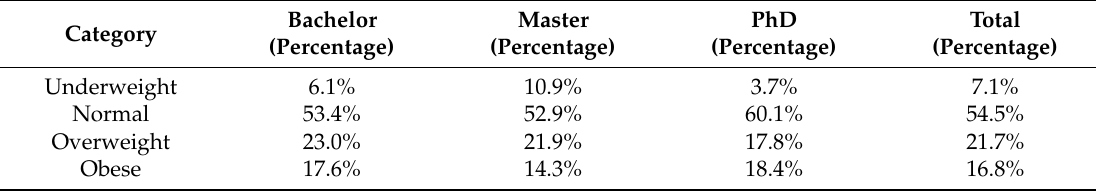
Table 3. BMI (Body Mass Index)